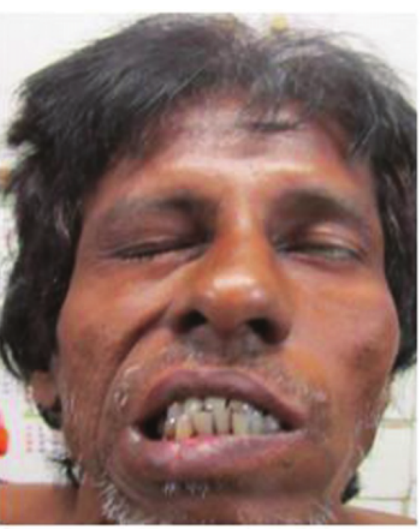
Figure 1: Patient had a left sided lower motor neuron type facial palsy.